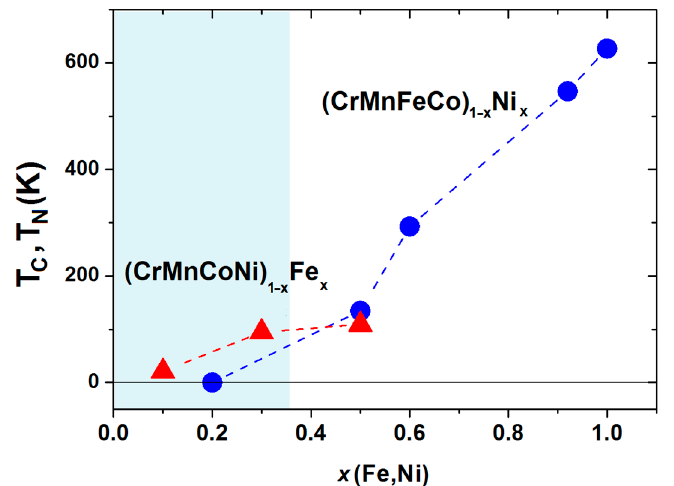
Figure 16. Magnetic phase diagrams of (CrMnFeCo) 1 − x Ni x and (CrMnCoNi) 1 − x Fe x alloys. Dashed lines are a guide for the eyes. T C and T N denote the Curie (circles) and peak/Neel (triangles) temperatures, respectively.